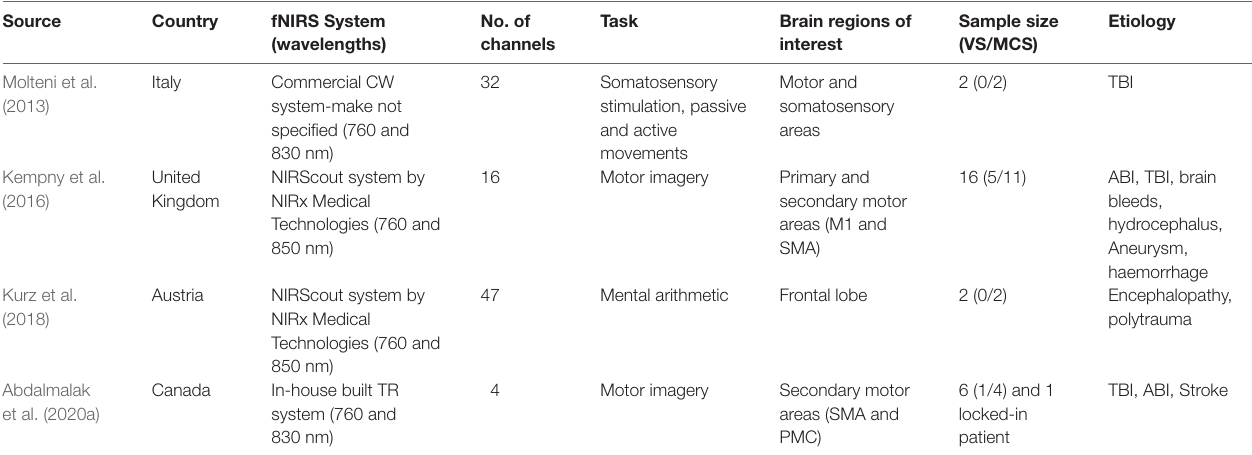
TABLE 1 | Summary of fNIRS studies conducted on DOC patients to